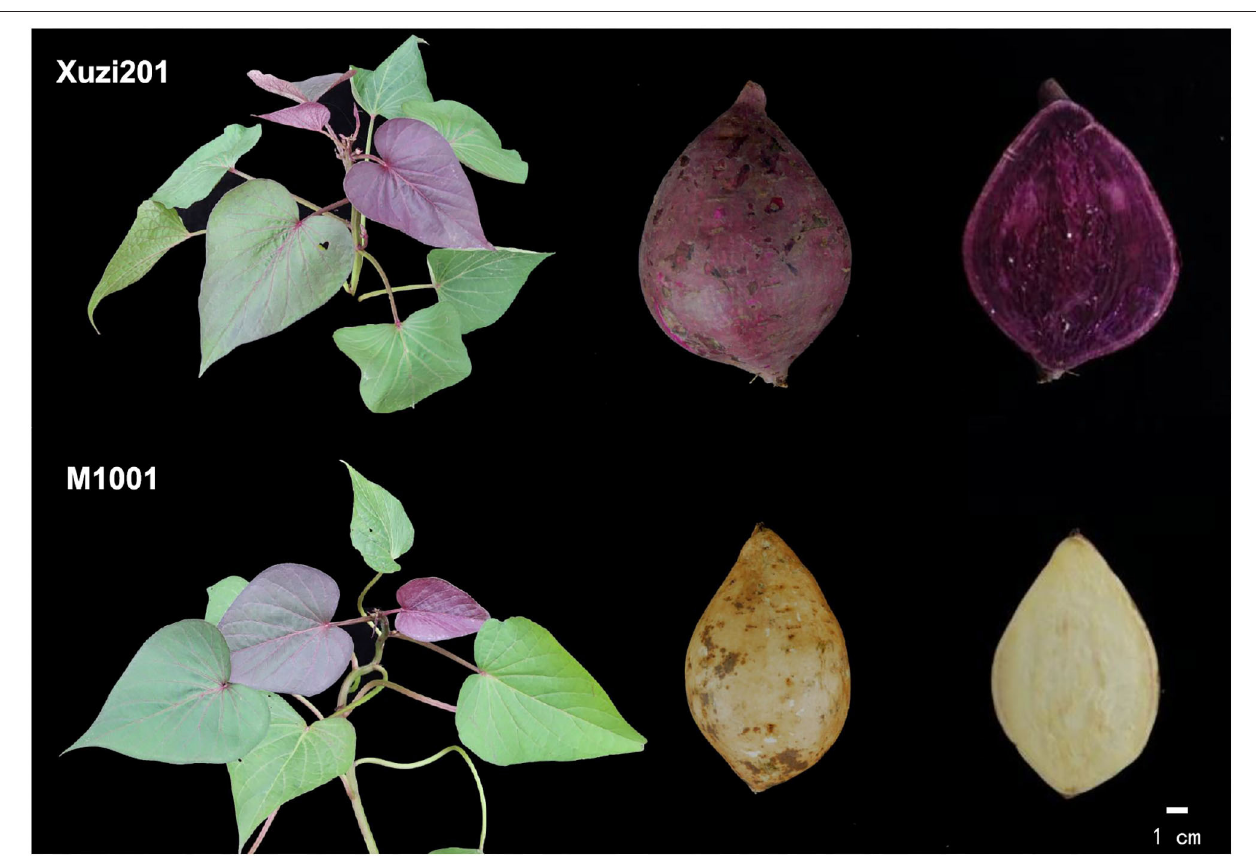
FIGURE 1 | Overview of aboveground parts, tuberous roots, and root fleshes from Xuzi201 and